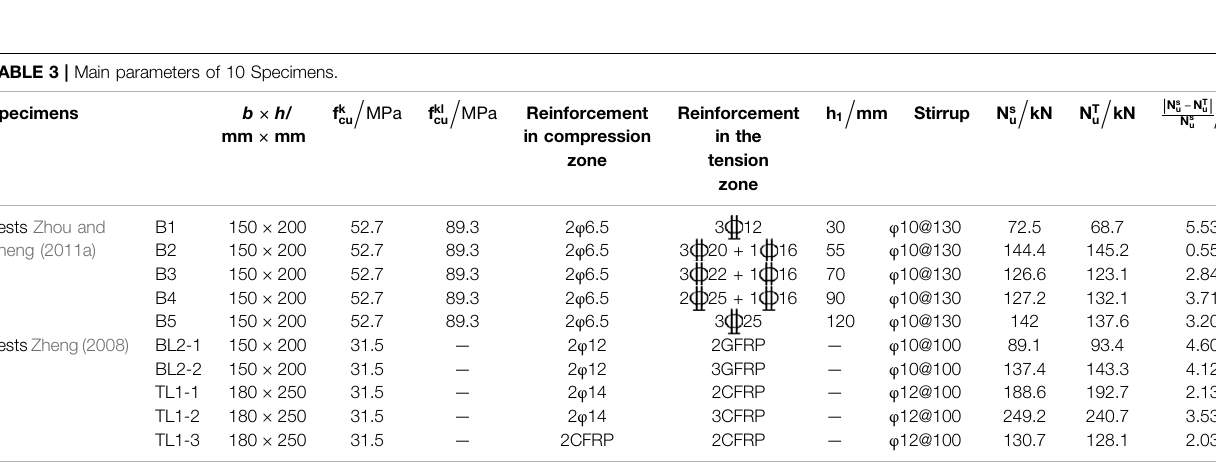
TABLE 3 | Main parameters of 10